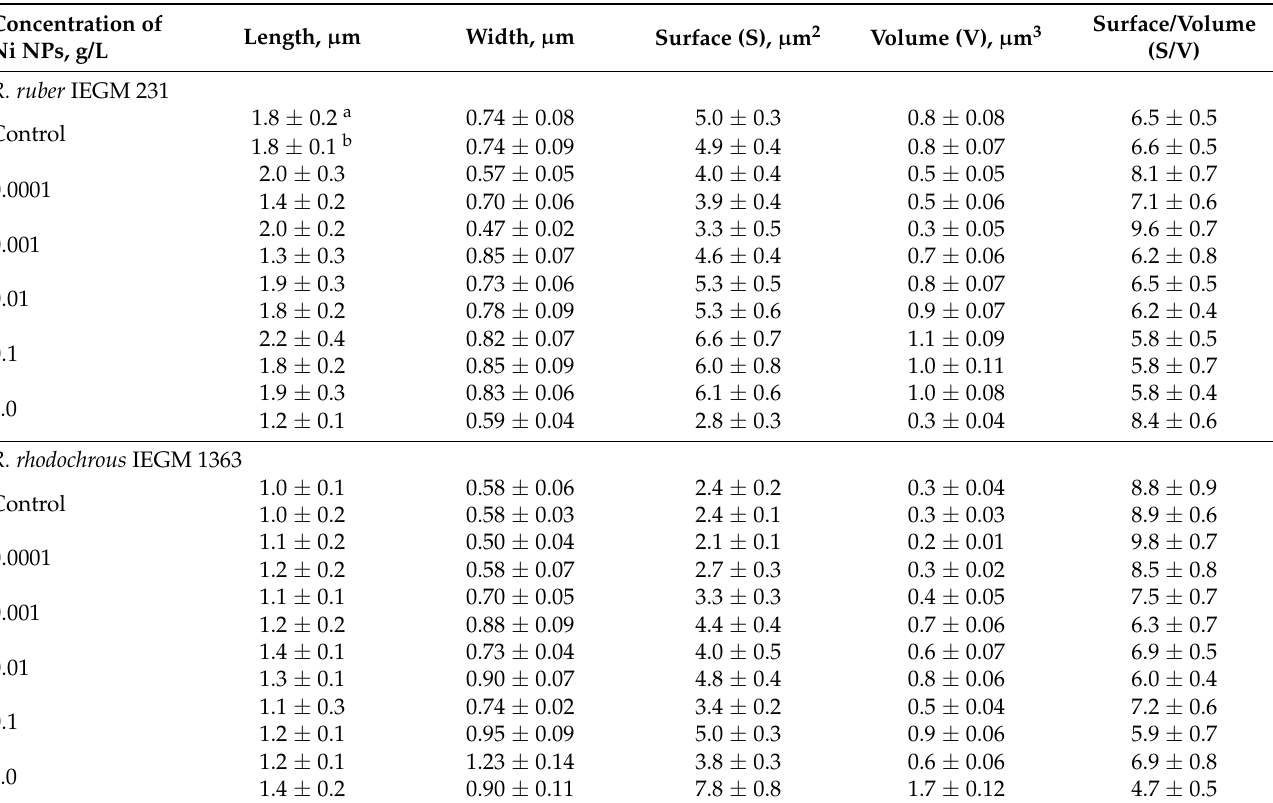
Table 1. Effects of Ni NPs on Rhodococcus cell